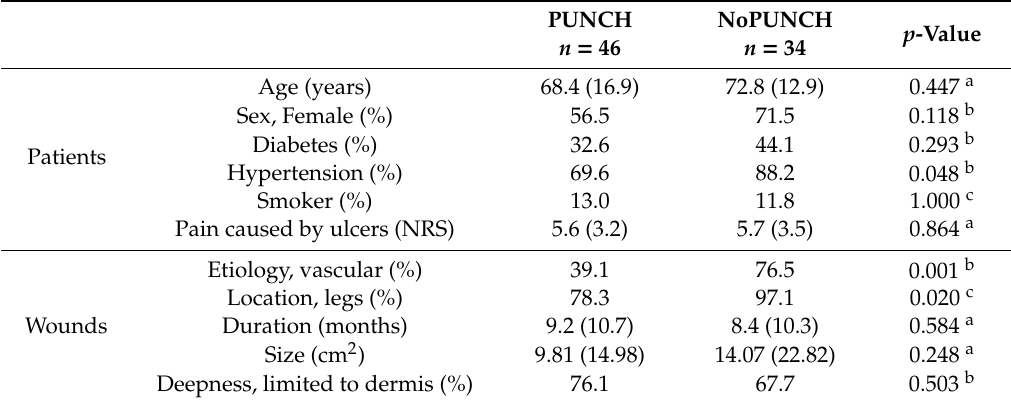
Table 1. Baseline characteristics of patients and wounds.